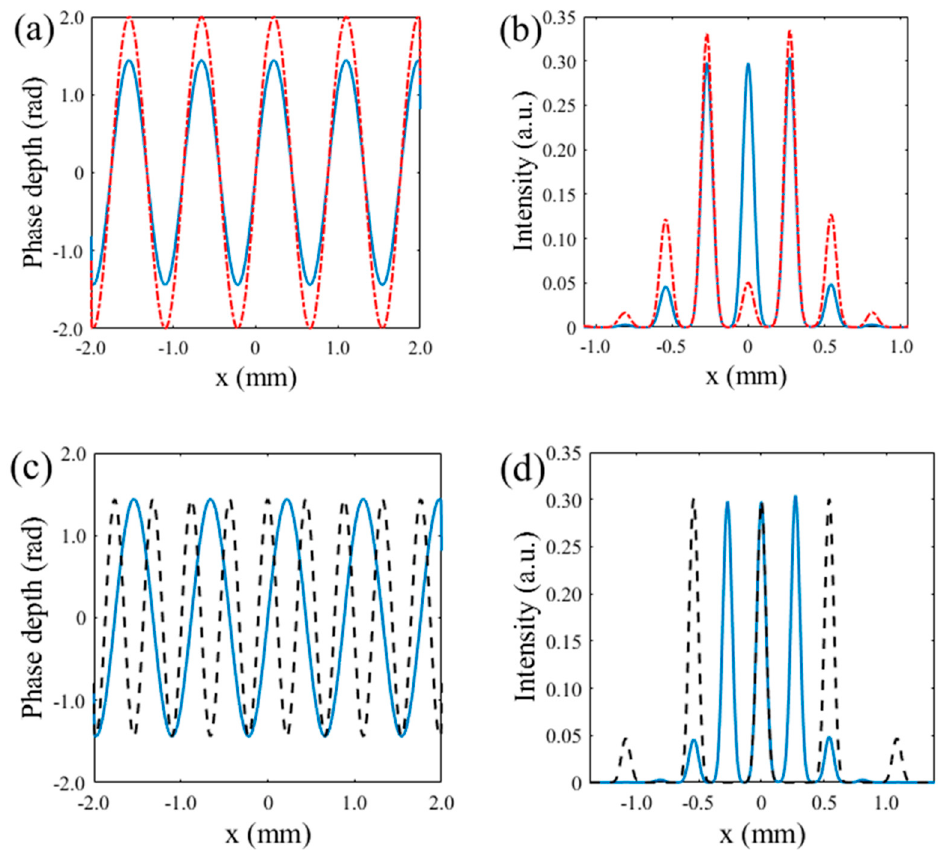
Figure 1. Holograms and the corresponding profiles of the generated spot array based on one sinusoid function with different amplitudes ( a , b ) or different periods ( c , d ).